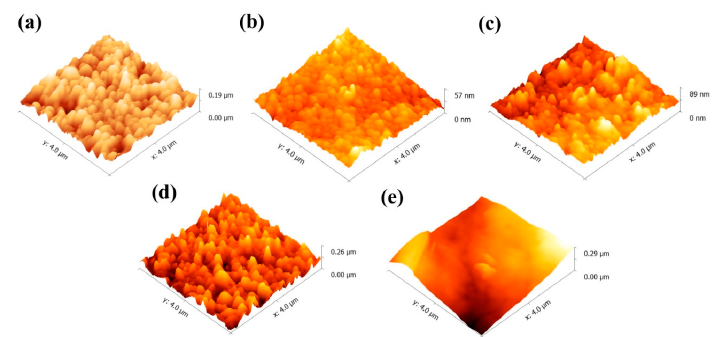
Figure 5. The atomic force microscope (AFM) images of ( a ) the perovskite layer and PCBM ETLs based on the ( b ) DCB, ( c ) CB, ( d ) MB, and ( e ) CF solvents.